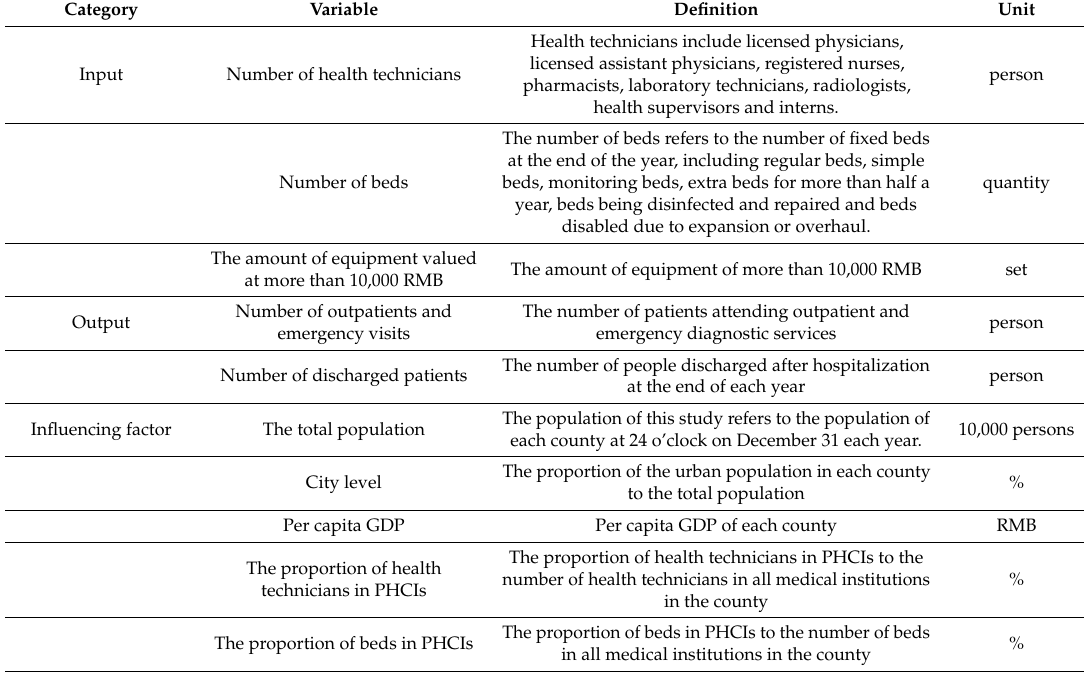
Table 1. Definitions of input, output and influencing factors